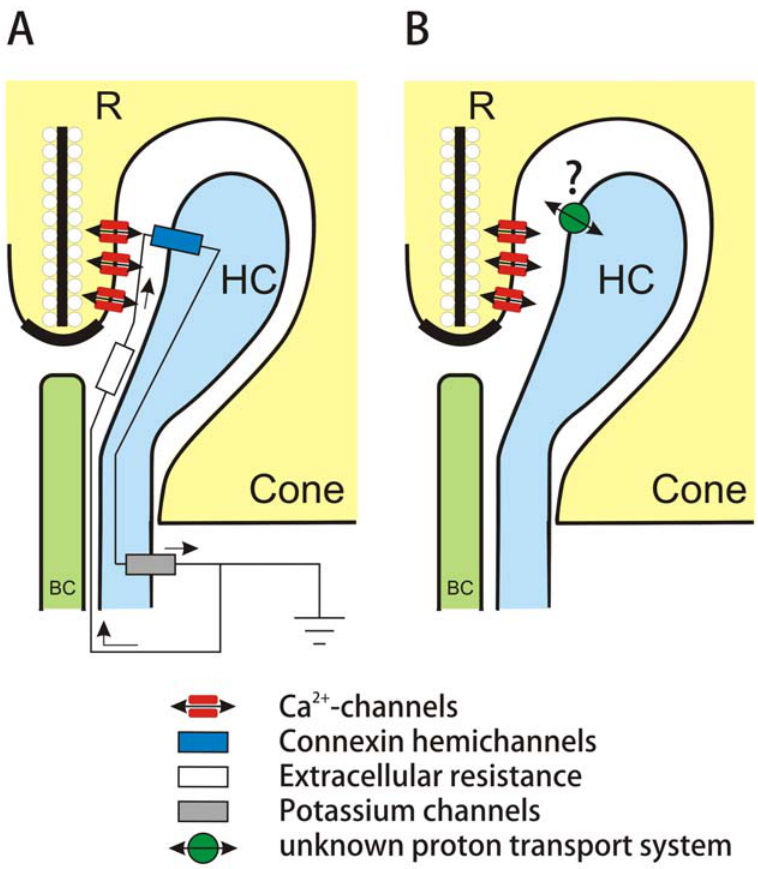
Figure 1. Schemeatic representation of the two feedback hypothesis. A) the ephaptic hypothesis and B) the pH hypothesis. The cone terminal is depicted with the invaginating HC and BC dendrites. The synaptic ribbon with the synaptic vesicles is indicated by ‘‘R’’. The voltage gated Ca-channels in the cone synaptic terminal are depicted in red. Hemichannels in the HC dendrites are indicated by the blue symbol. The white symbol indicate the extracellular resistance and the gray symbol the potassium channels in the HCs. The green symbol indicates an unidentified proton transport system.